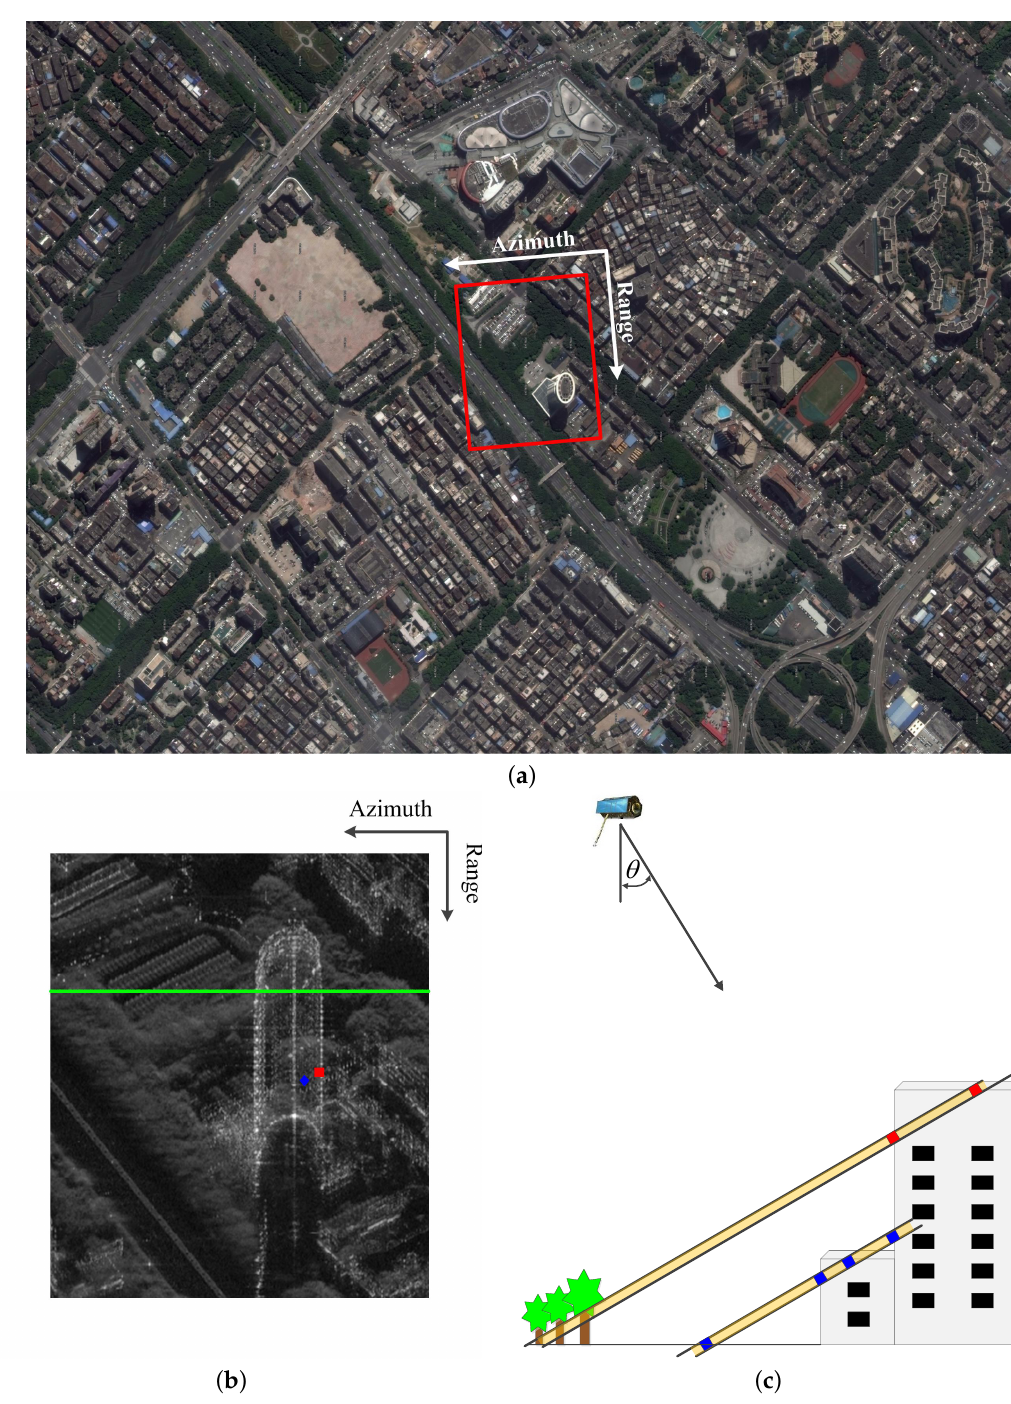
Figure 10. Images of the study area: ( a ) optical image from Google Earth under study, with the building in the red box; ( b ) mean intensity map of the spotlight TerraSAR-X, with the red square and blue diamond the positions of the detected triple scatterers in SAR image, whose elevations are depicted in Figure 14; and ( c ) schematic drawing of possible signal contributions in a single azimuth-range pixel (size of resolution cells not to